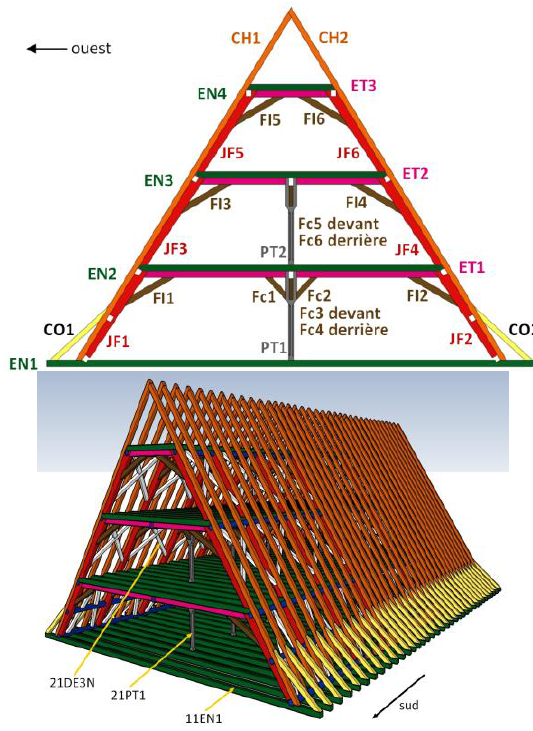
Figure 12: Model of added chimneys